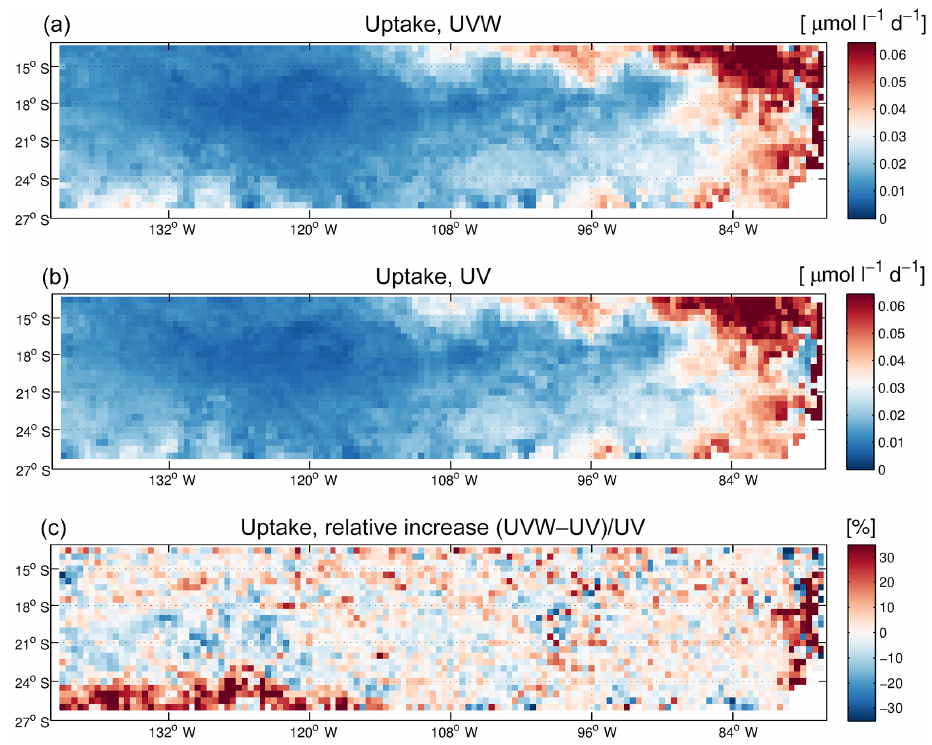
Figure 6. Nitrate uptake rates considering (a) both QG vertical velocity and geostrophic horizontal velocity (UVW); (b) only geostrophic horizontal velocity (UV); (c) relative increase of nitrate uptake rates when including vertical velocity. These fields were obtained for r = 10 days, U 0 = 0 . 1µmolL − 1 d − 1 , K E = 1µEm − 2 s − 1 and K N = 0 . 2µmolL − 1